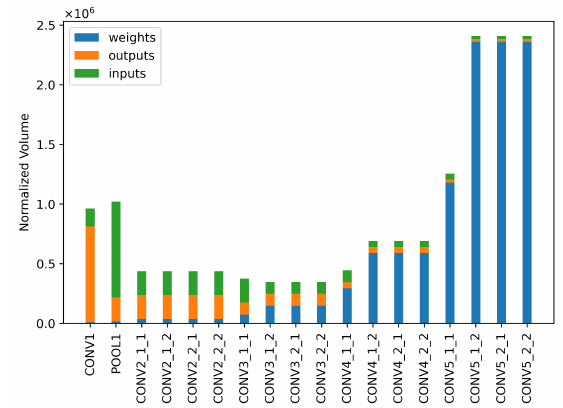
Figure 4. Normalized data volumes for ResNet18.